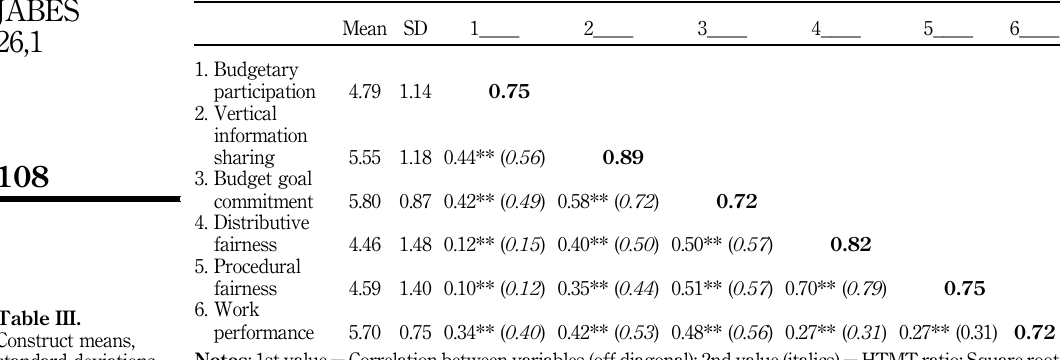
Table III. Construct means, standard deviations and